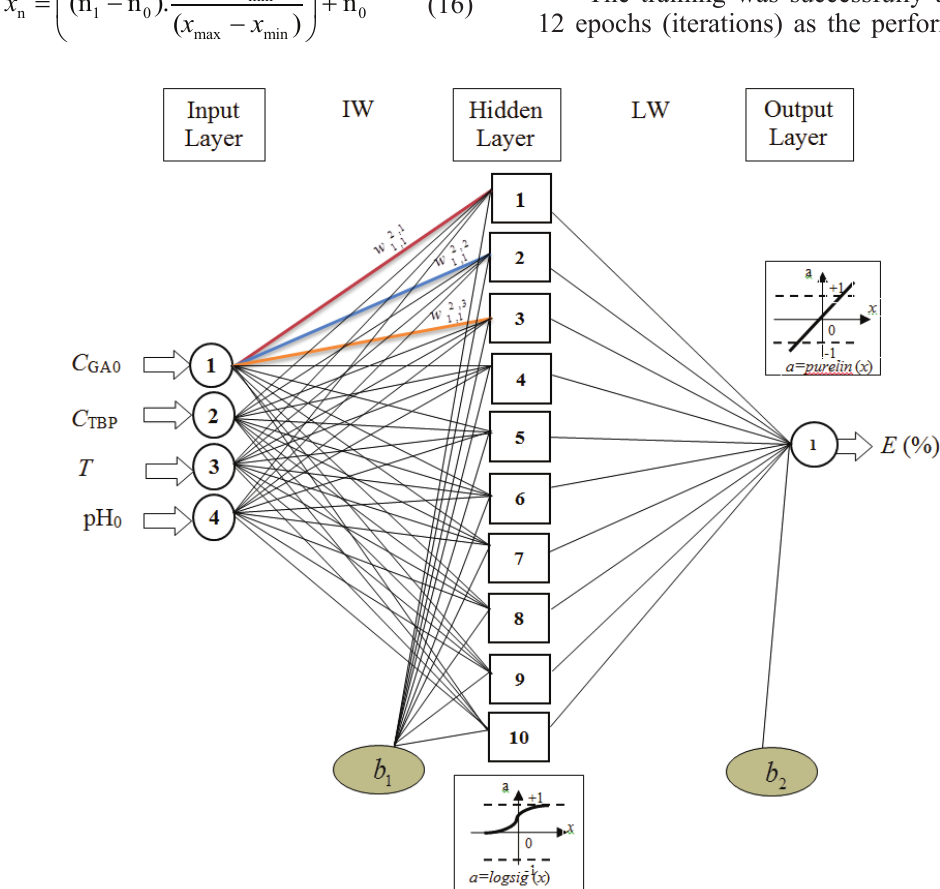
Fig. 4 ANN architecture used for the prediction of GA extraction efficiency Fig. 4 – ANN architecture used for the prediction of GA extraction